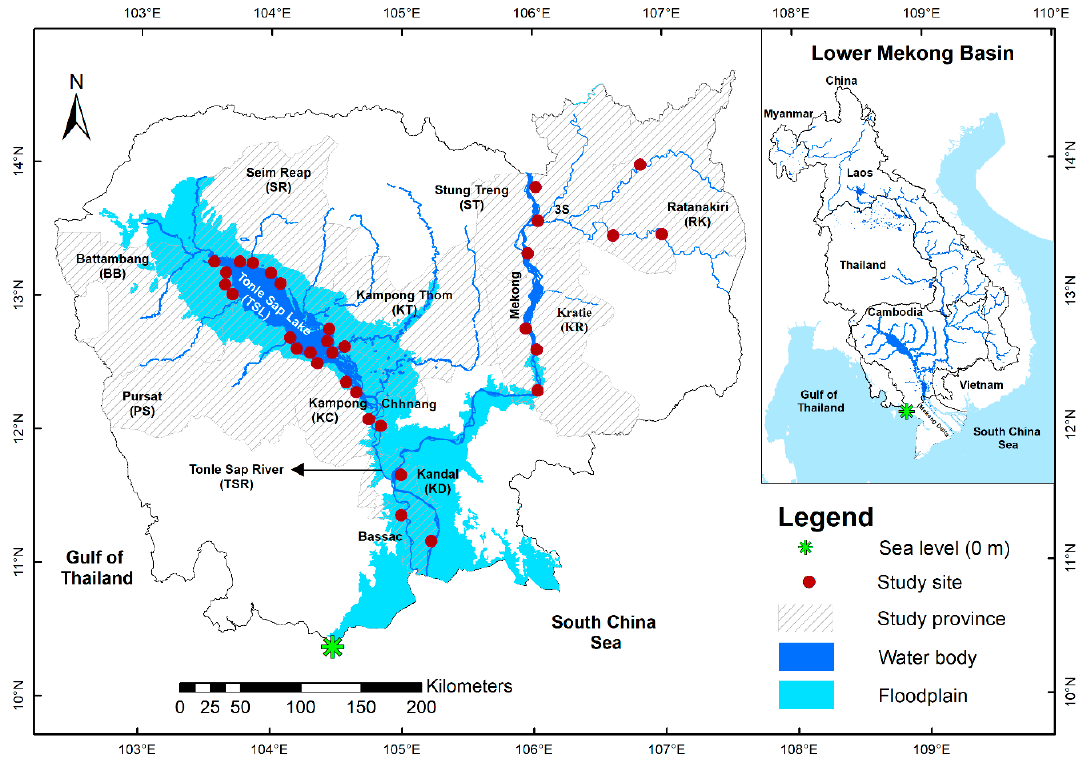
Figure 1. Fish monitoring sites covering the main inland water bodies in Cambodia.